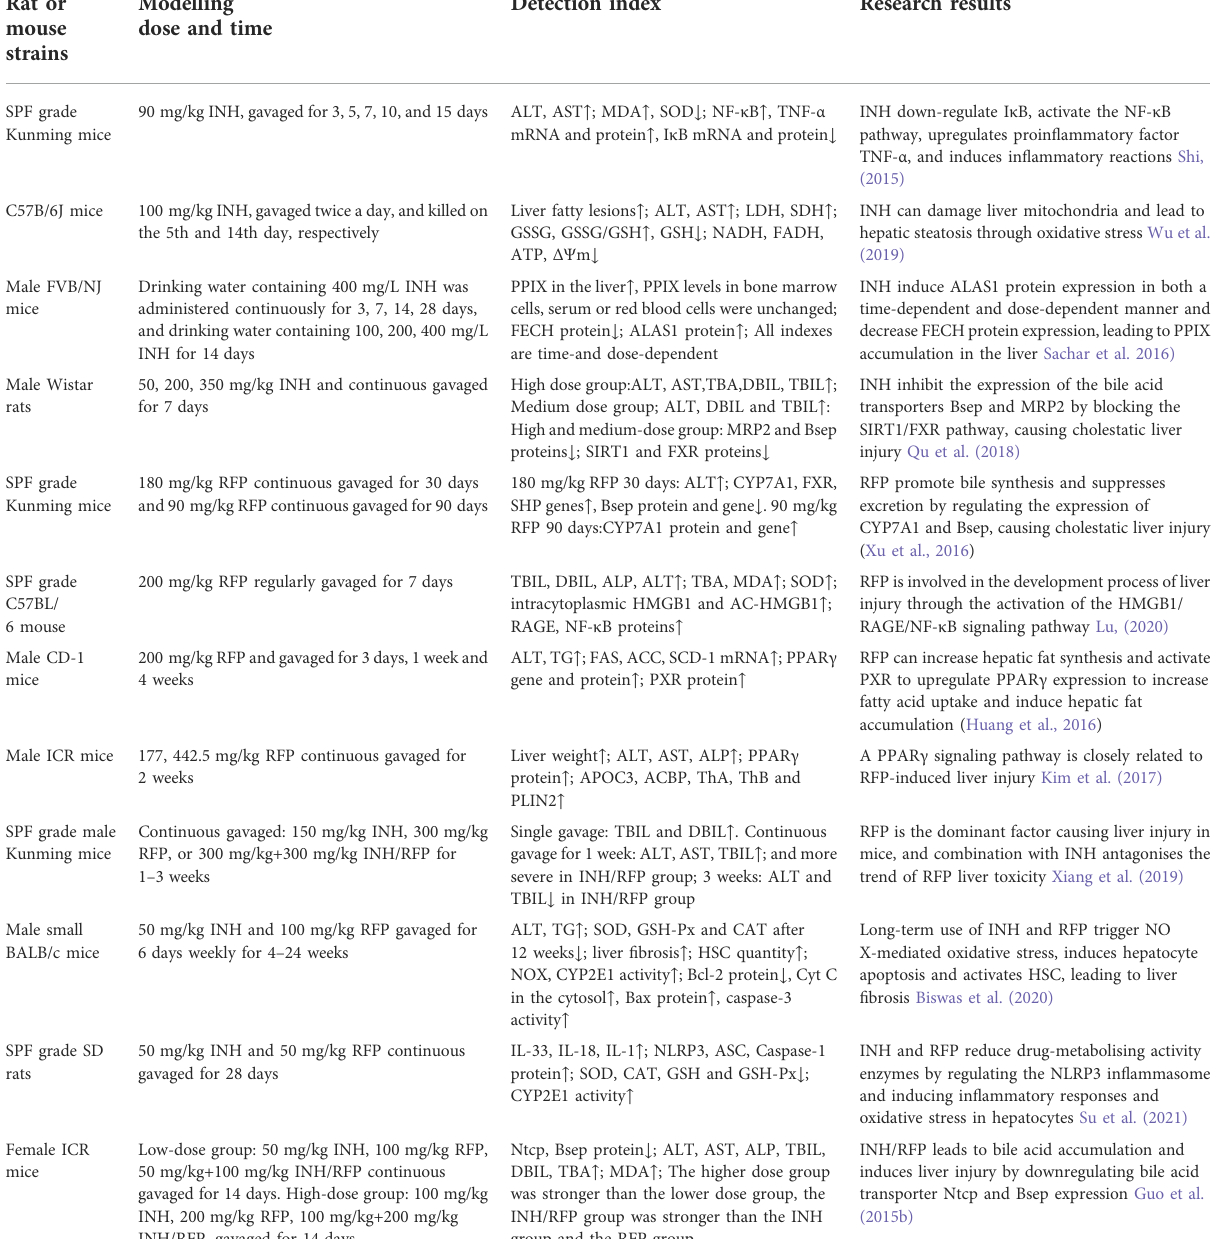
TABLE 1 INH and RFP liver injury model and summary of research